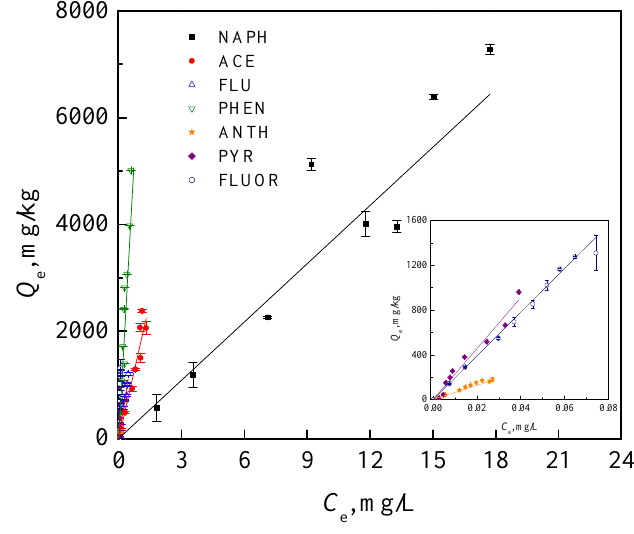
Figure 5. Isothermal biosorption of different PAHs onto inactive biomass. Table 3. Isothermal parameters of the biosorption of PAHs onto biomass using Freundlich and linear